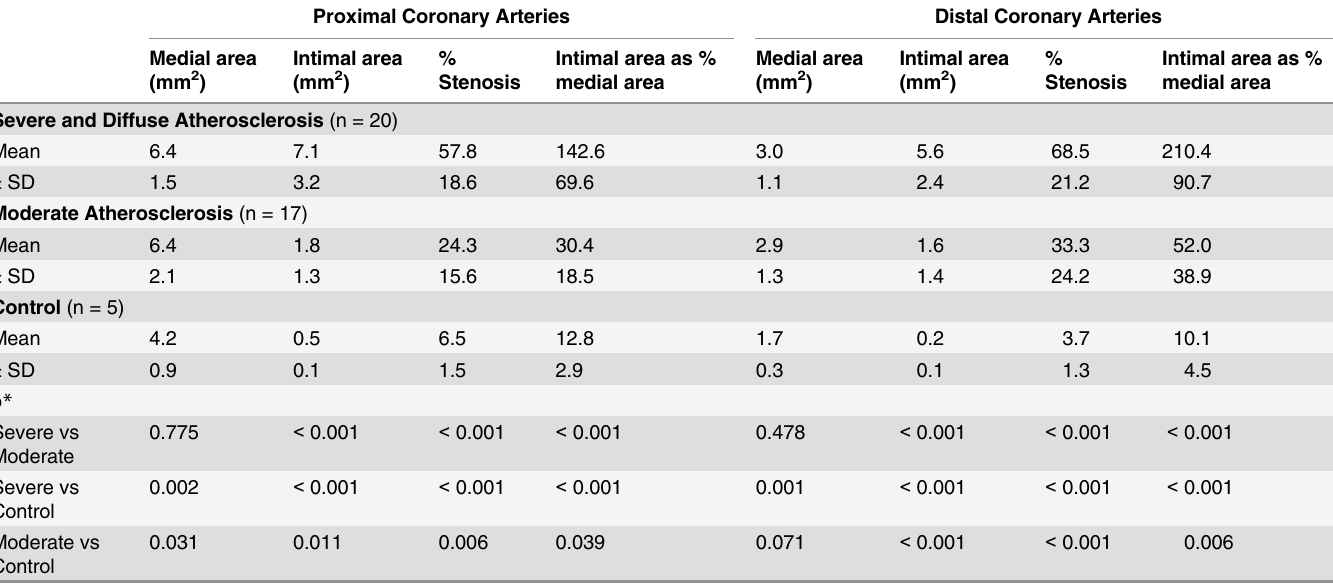
Table 1. Proximal and Distal Coronary Artery Atherosclerosis Morphometry.